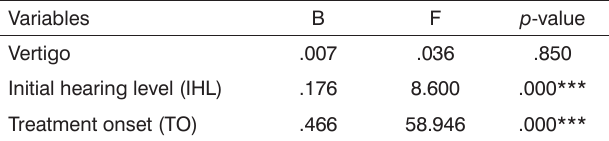
Table 3. Results of regression analysis with vertigo, initial hearing level, and treatment